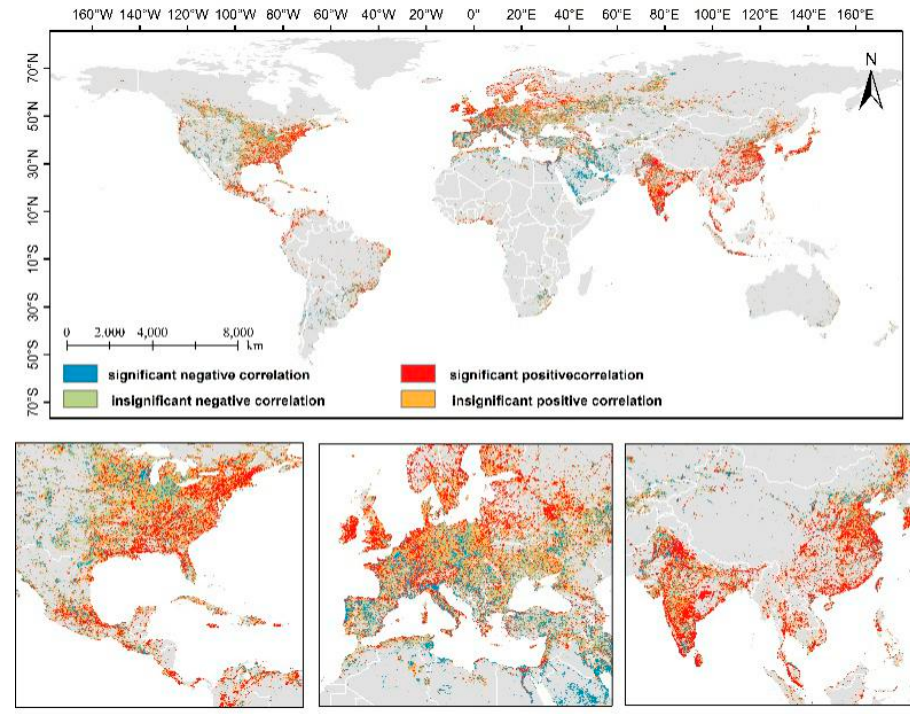
Figure 6. Global maps of correlation coefficients between annual averages NDVI and nighttime lights index form 2000–2013.